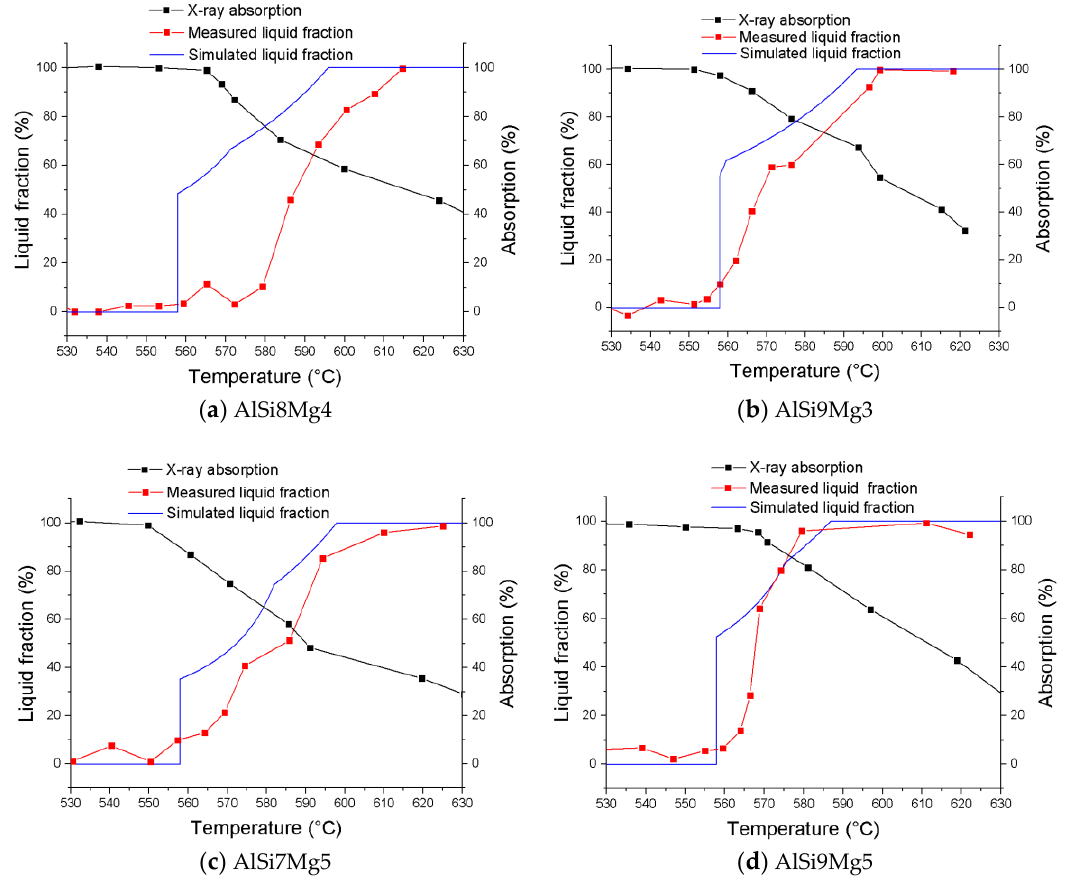
Figure 9. Development of the liquid phase over temperature extracted from the density maps of diffracted intensities (in red, see also Figure 8), calculated curves (in blue) and X-ray absorption of the samples related to the absorption of the precursors during foaming of ( a ) AlSi8Mg4, ( b ) AlSi9Mg3, ( c ) AlSi7Mg5, and ( d ) AlSi9Mg5 alloys.